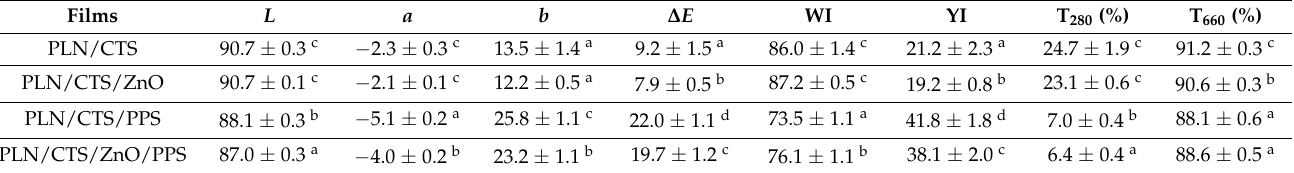
Figure 3. The appearance and transmittance spectra of the pullulan/chitosan-based composite films. Table 1. Surface color and transmittance of pullulan/chitosan-based bioactive composite